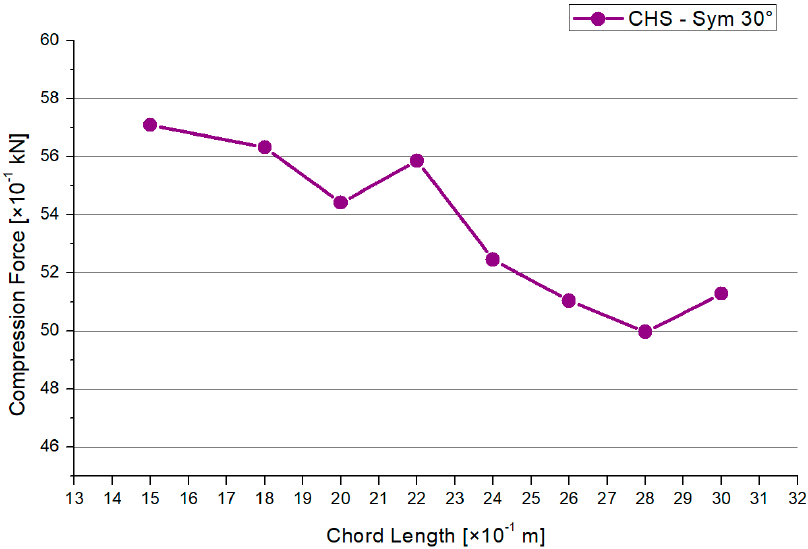
Figure 8. Results—Maximum Compression Force.